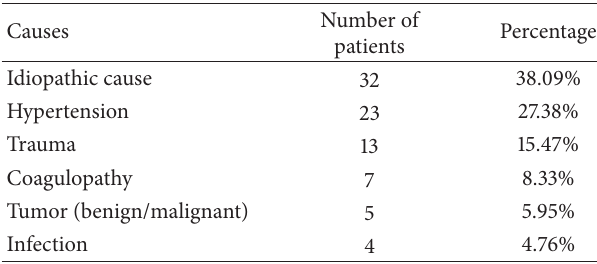
Table 1: Etiology of epistaxis ( 𝑛 = 84